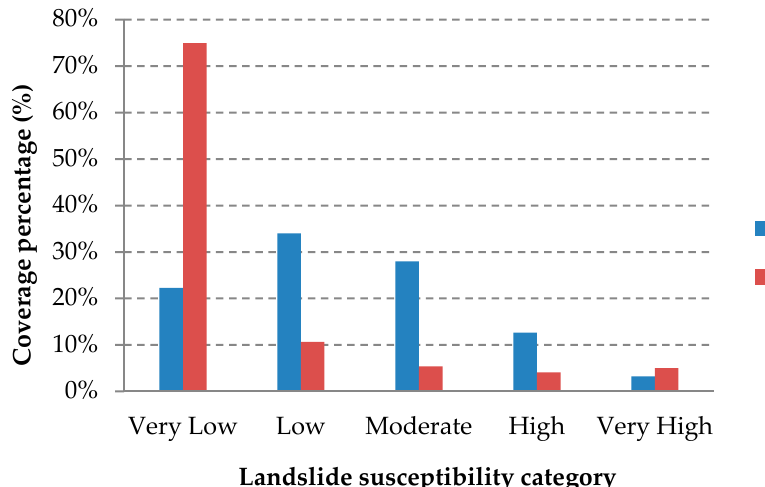
Figure 3. Landslide susceptibility map produced by: ( a ) FR model; ( b ) LR model.